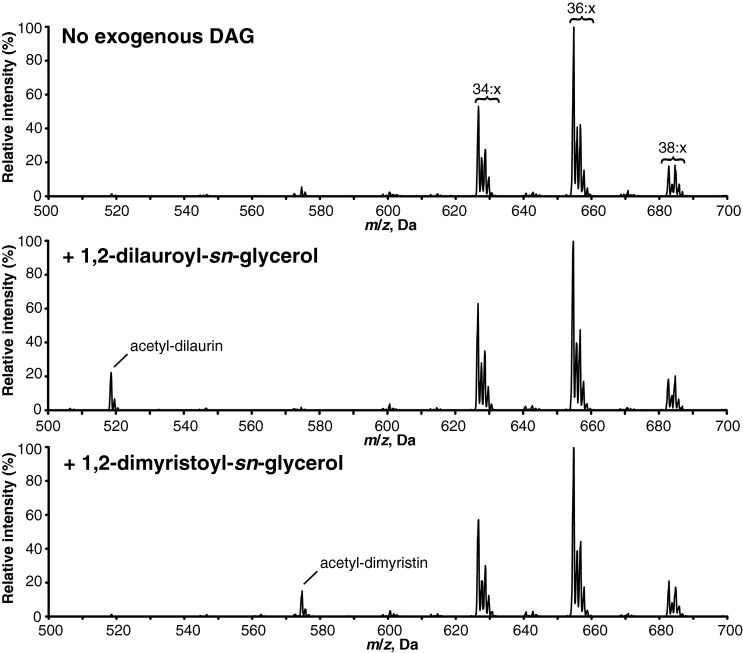
EaDAcT can acetylate DAG containing different chain length fatty acidsPositive ESI mass spectra obtained from the neutral loss of ammonium acetate from lipid products resulting from incubating microsomes containing EaDAcT with acetyl-CoA and different exogenous DAG substrates. Peaks correspond to m/z values of the [M+NH4]+ adduct of the intact acetyl-TAG molecule. The number of acyl carbons in each series of acetyl-TAG molecules is indicated; for clarity, the number of double bonds (x) is not defined.